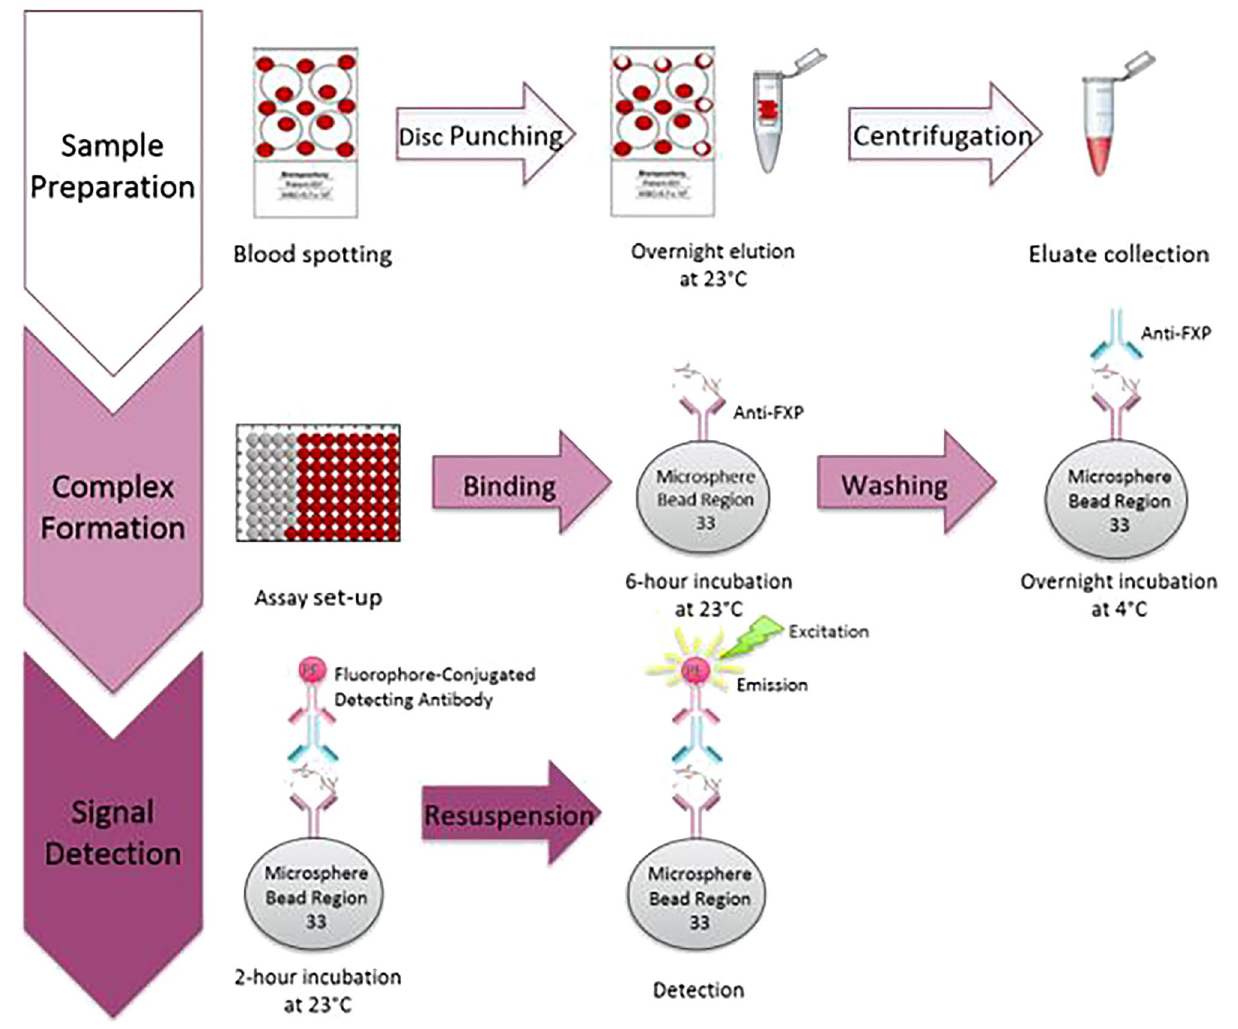
Figure 1. Experimental workflow of the optimized FXP assay. FXP Fragile X